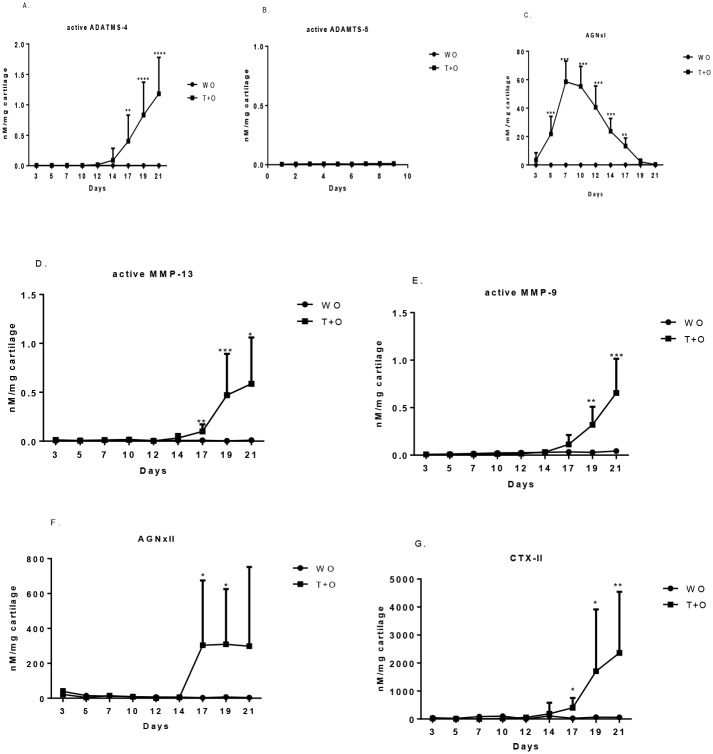
Profiling of active aggrecanases, MMPs and their specific aggrecan degradation fragments into bovine explants upon T+O stimulation.The releases of (A)active ADAMTS-4.: (D) active MMP-13, (E) active MMP-9, (F)AGNxII and (G)CTX-II started since day 14 and increased over time, while (B) active ADAMTS-5 was unable to be detected during the 21 days. (C) Aggrecanase-mediated aggrecan fragment’s levels peaked at day 7, afterwards, declined to background levels at day 21. No any release of any biomarkers was seen in the WO group. All values were shown as mean ±95% confidence intervals (n = 8 in each group). Error bars indicated the upper limit of 95% confidence intervals.